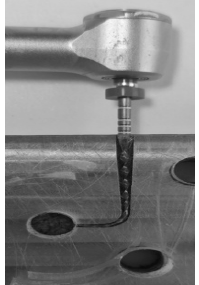
Figure 1. Device for cyclic fatigue resistance tests.